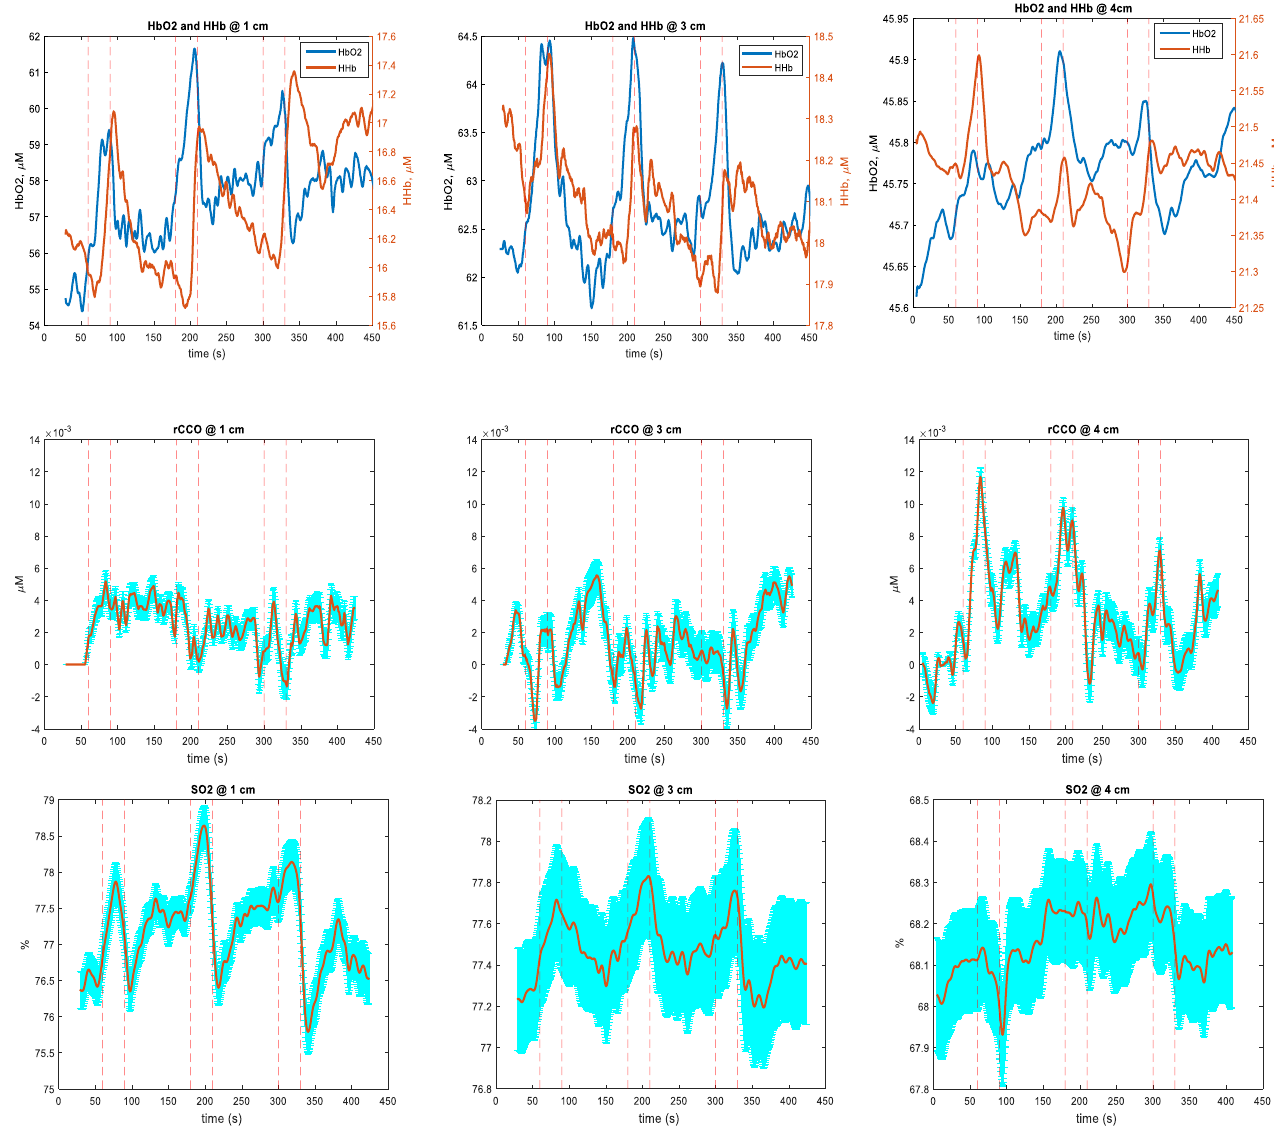
Figure 4. Cross-subject averaged changes in [HbO2], [HHb], and [rCCO], and regional SO 2 measured at 1 cm, 3 cm, and 4 cm using the homogeneous tissue model and 750–900nm waveband. Blue color shows the cross-subject standard deviations.